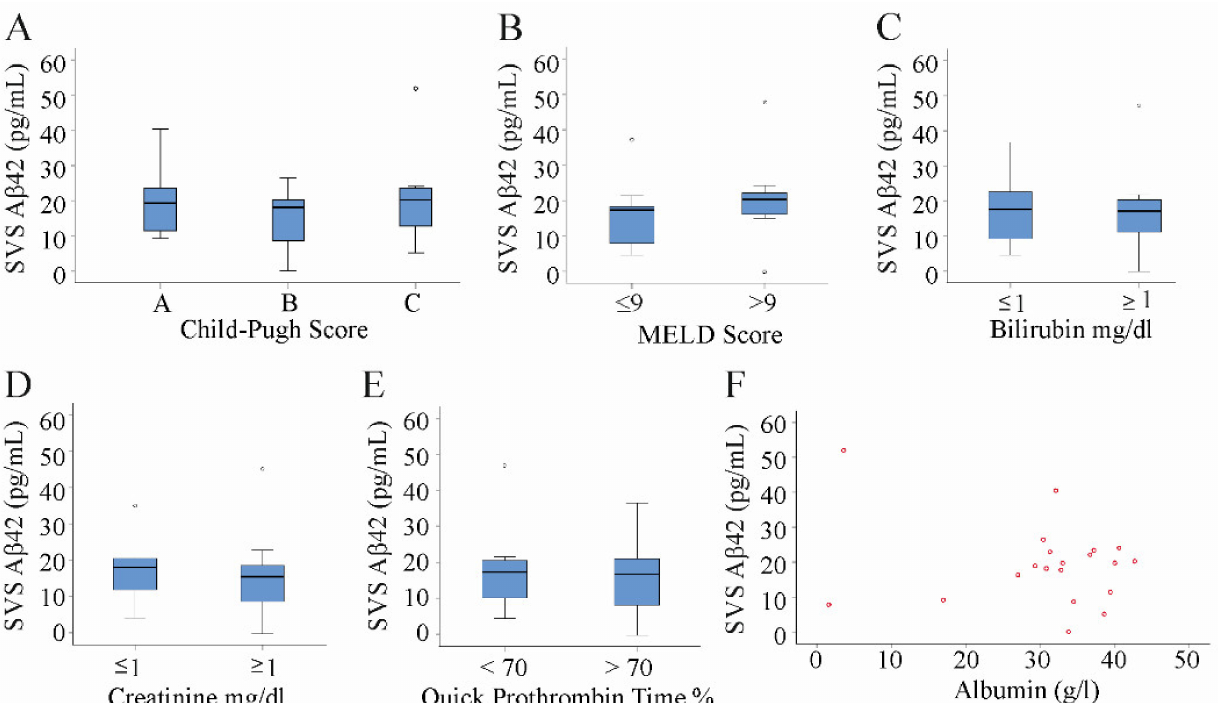
Figure 2. A β 42 in relation to liver function. A β 42 in serum of patients with liver cirrhosis stratified for ( A ) the Child–Pugh score (A = six patients, B = six patients, and C = eight patients) or ( B ) the median MELD score (nine patients had a MELD above 9 and 11 patients a MELD score ≤ 9). ( C ) A β 42 serum levels in patients with a bilirubin value below (eight patients) or above (12 patients) the upper normal value (1 mg/dL). ( D ) A β 42 serum levels in patients with creatinine levels below (eight patients) or above (12 patients) the upper normal value (1 mg/dL). ( E ) A β 42 serum levels in patients with a normal (<70%, 10 patients) or a prolonged (>70%, 10 patients) Quick prothrombin time. ( F ) Spearman analysis showed that A β 42 serum levels did not correlate with albumin in the 20